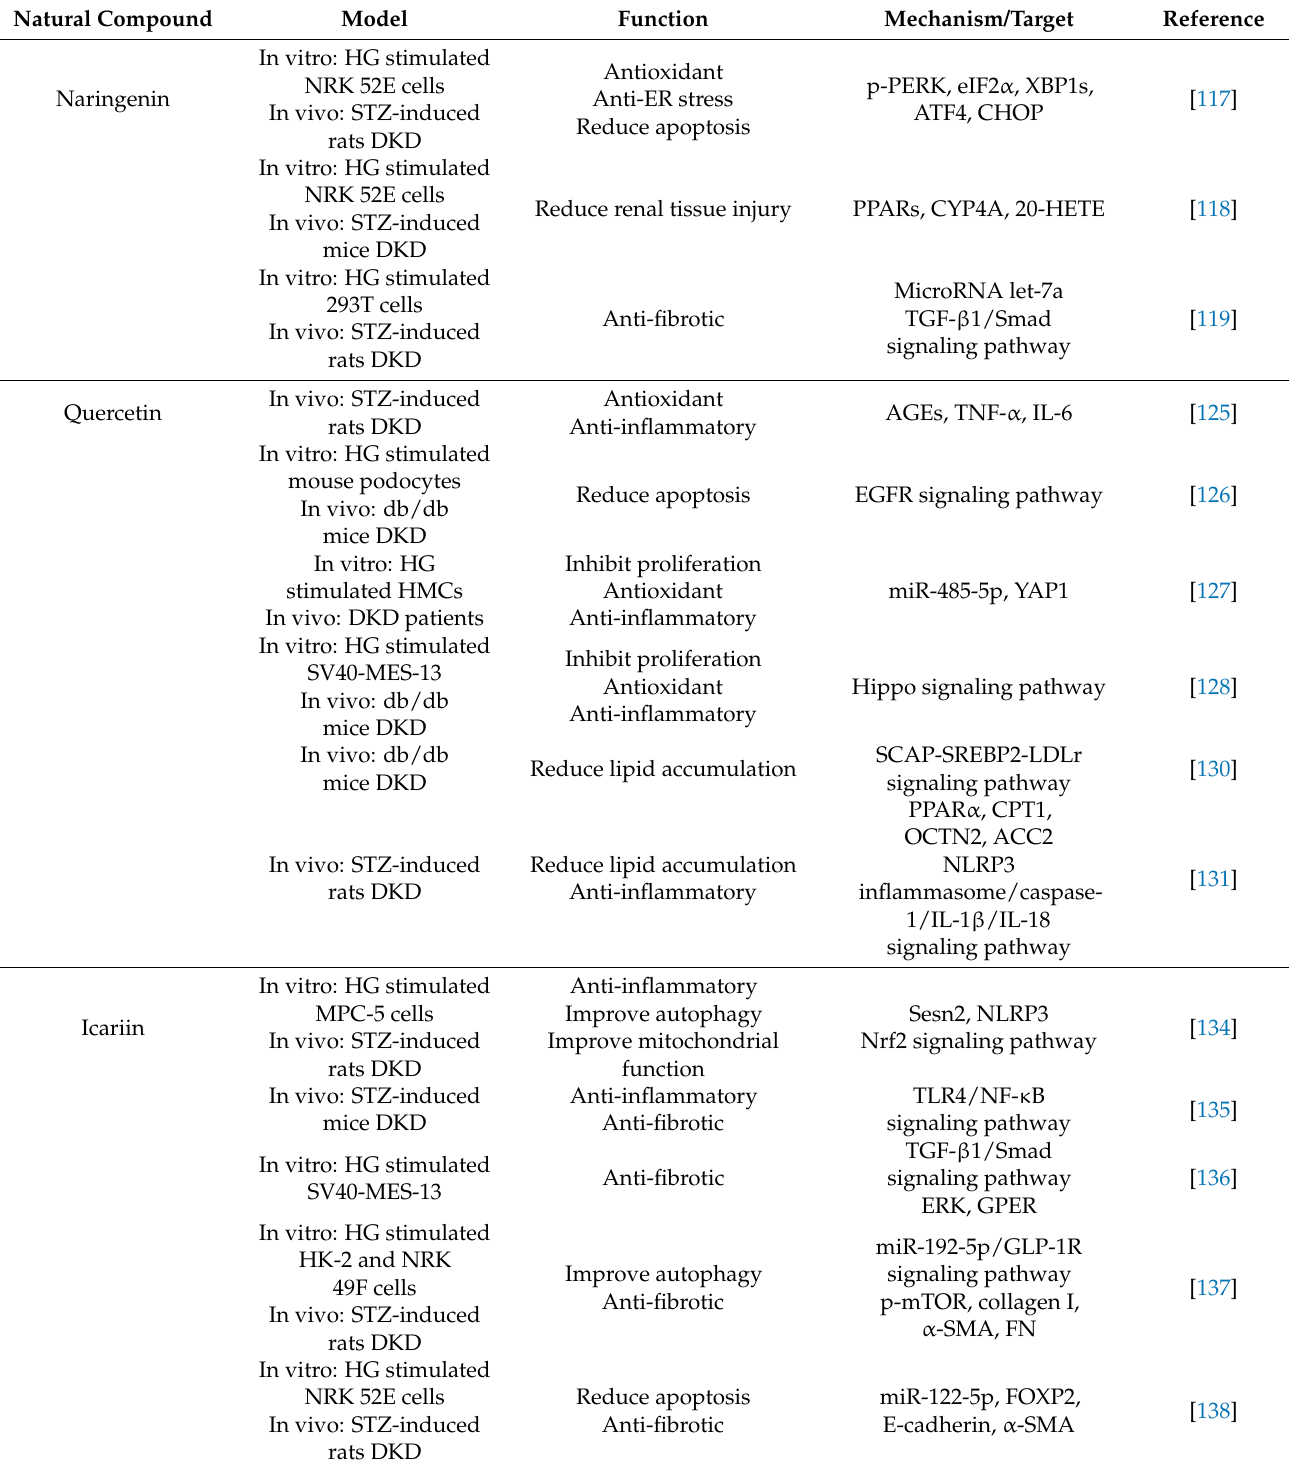
Table 3 summarizes the available data on flavonoids’ activities and the mechanisms of their action. Table 3. Mechanisms of flavonoids in the treatment of